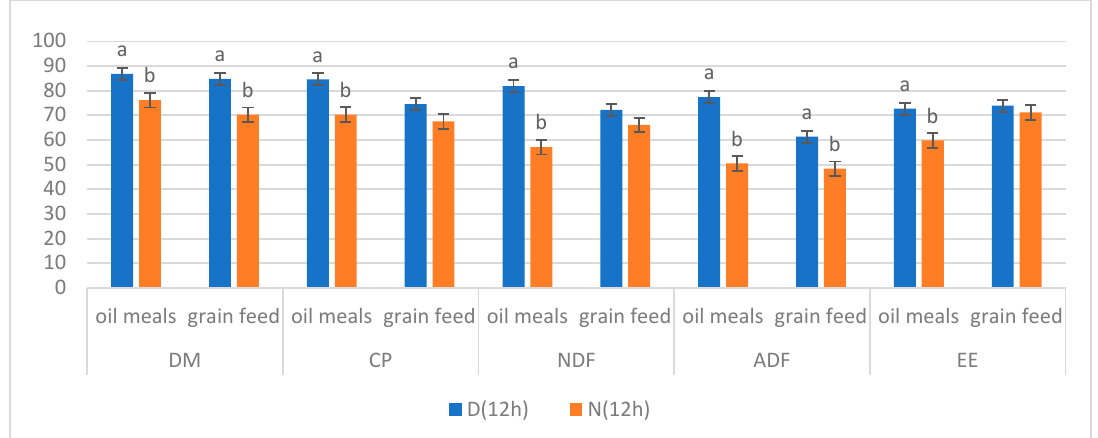
Figure 1. Rumen digestibility of concentrate nutrients during the day and night as a percentage of the whole day, respectively (%, dry matter basis). Different letters in the figure indicate significant differences ( p < 0.05), while no letters indicate insignificant differences ( p > 0.05).